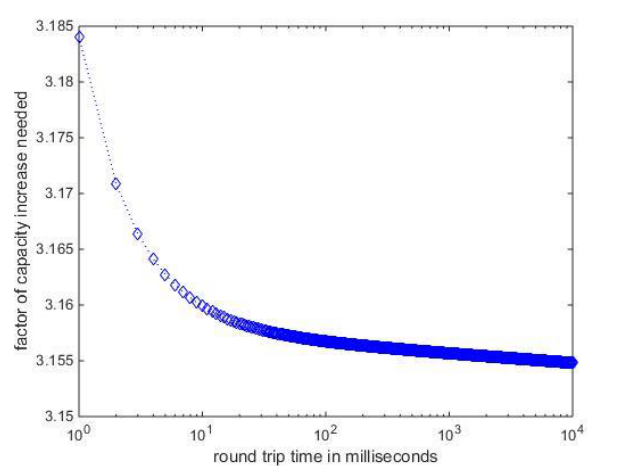
Figure 1. Capacity increase factor for C = 1GB and Q = 1000